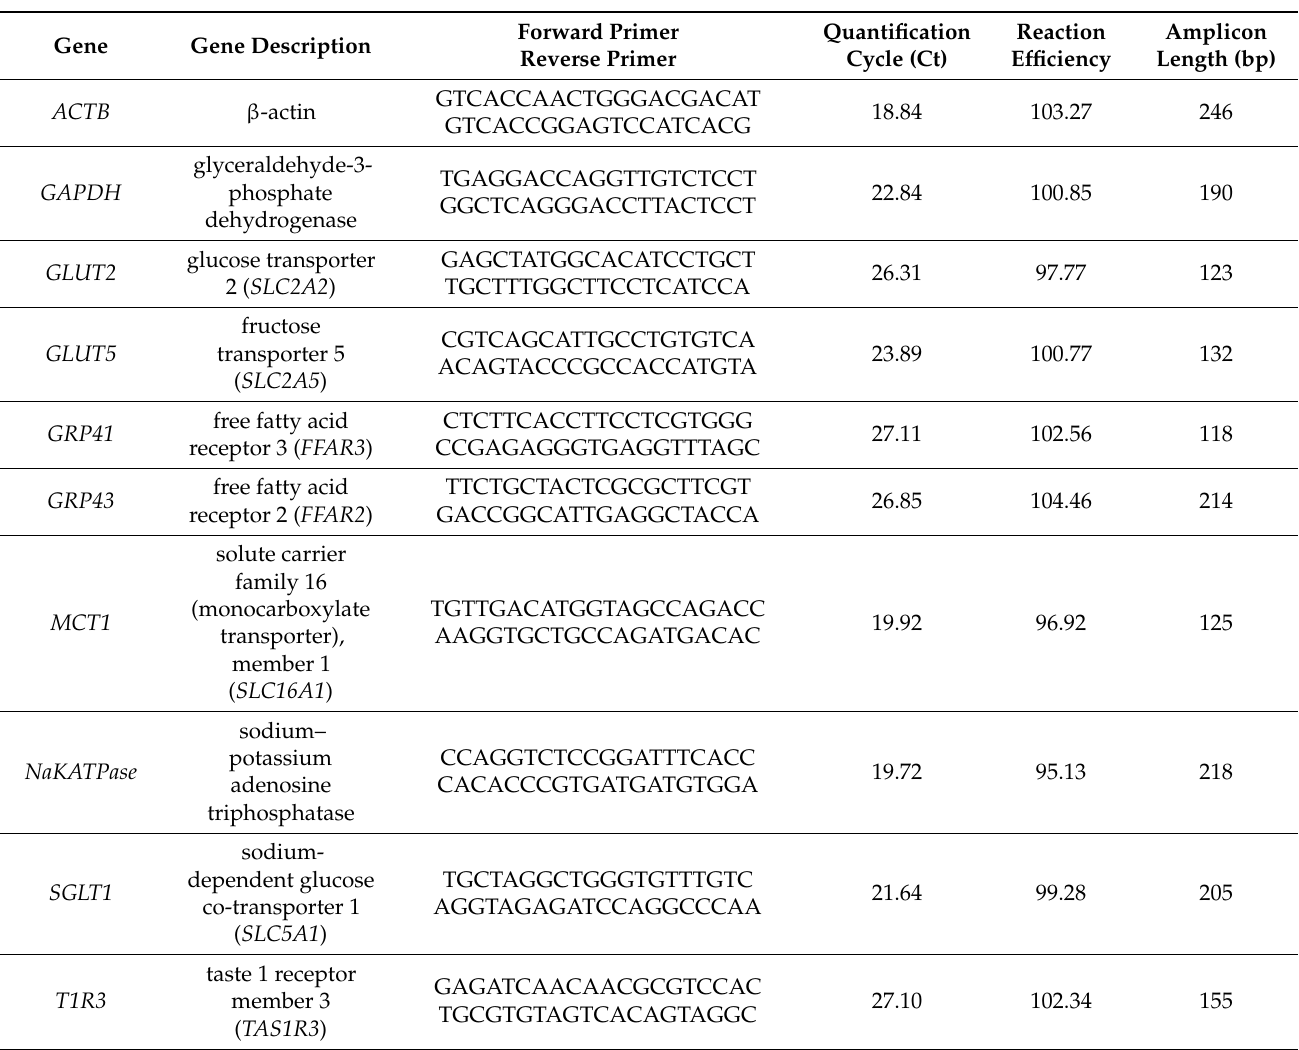
Table 1. Primers used for determination of mRNA